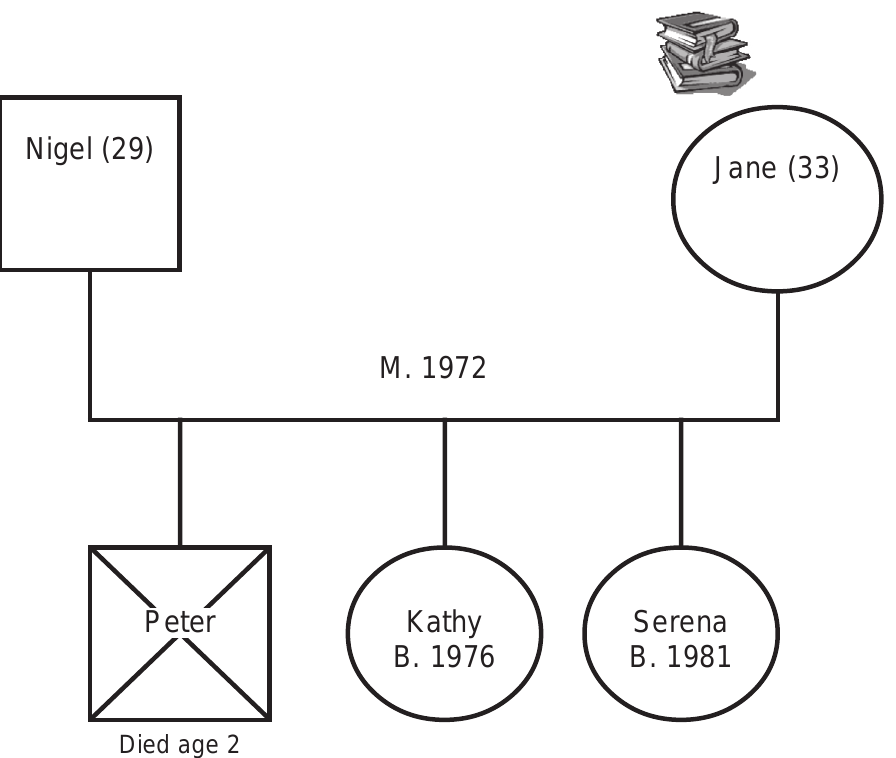
Figure 2: Genograph of Nigel and Jane Ford: A visual representation of the dominant context (education) in the story of Nigel and Jane